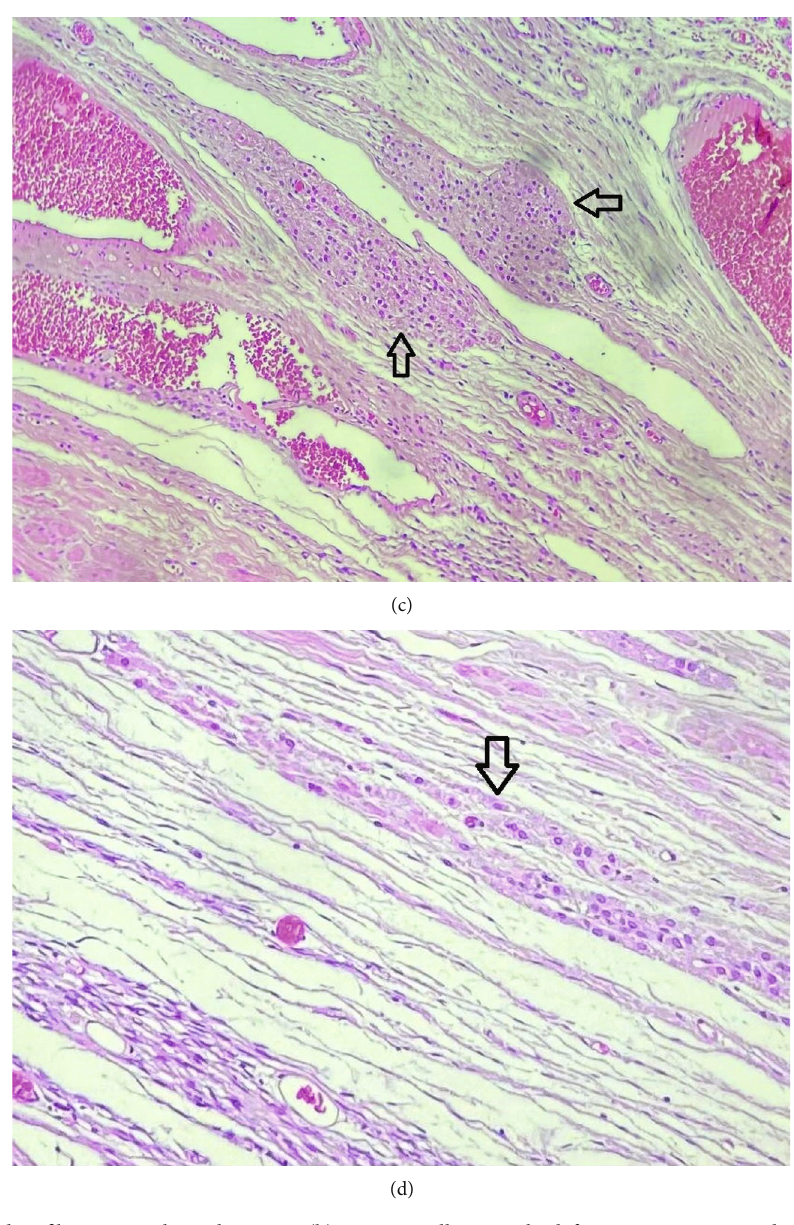
Figure 2: (a) Ovarian adeno fi broma on the right ovary. (b) Cystic swelling on the left ovary: serous cystadeno fi broma. (c) Clusters of luteinized cells (arrows) on the ovarian stroma; hematoxylin – eosin 400 × . (d) Cluster of luteinized stromal cells (arrow) and adjacent stromal